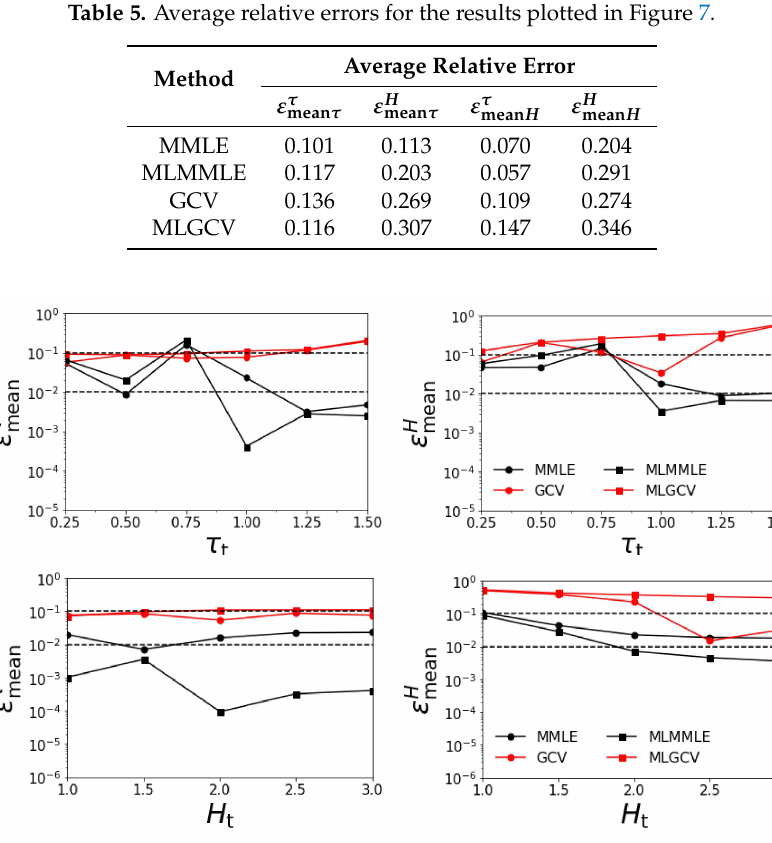
Figure 6. Relative errors ε τ mean and ε H mean versus τ t for H t = 3.0 km (upper panels) and H t for τ t = 1.0 (lower panels). The surface albedo is included in the retrieval and all four aerosol models are